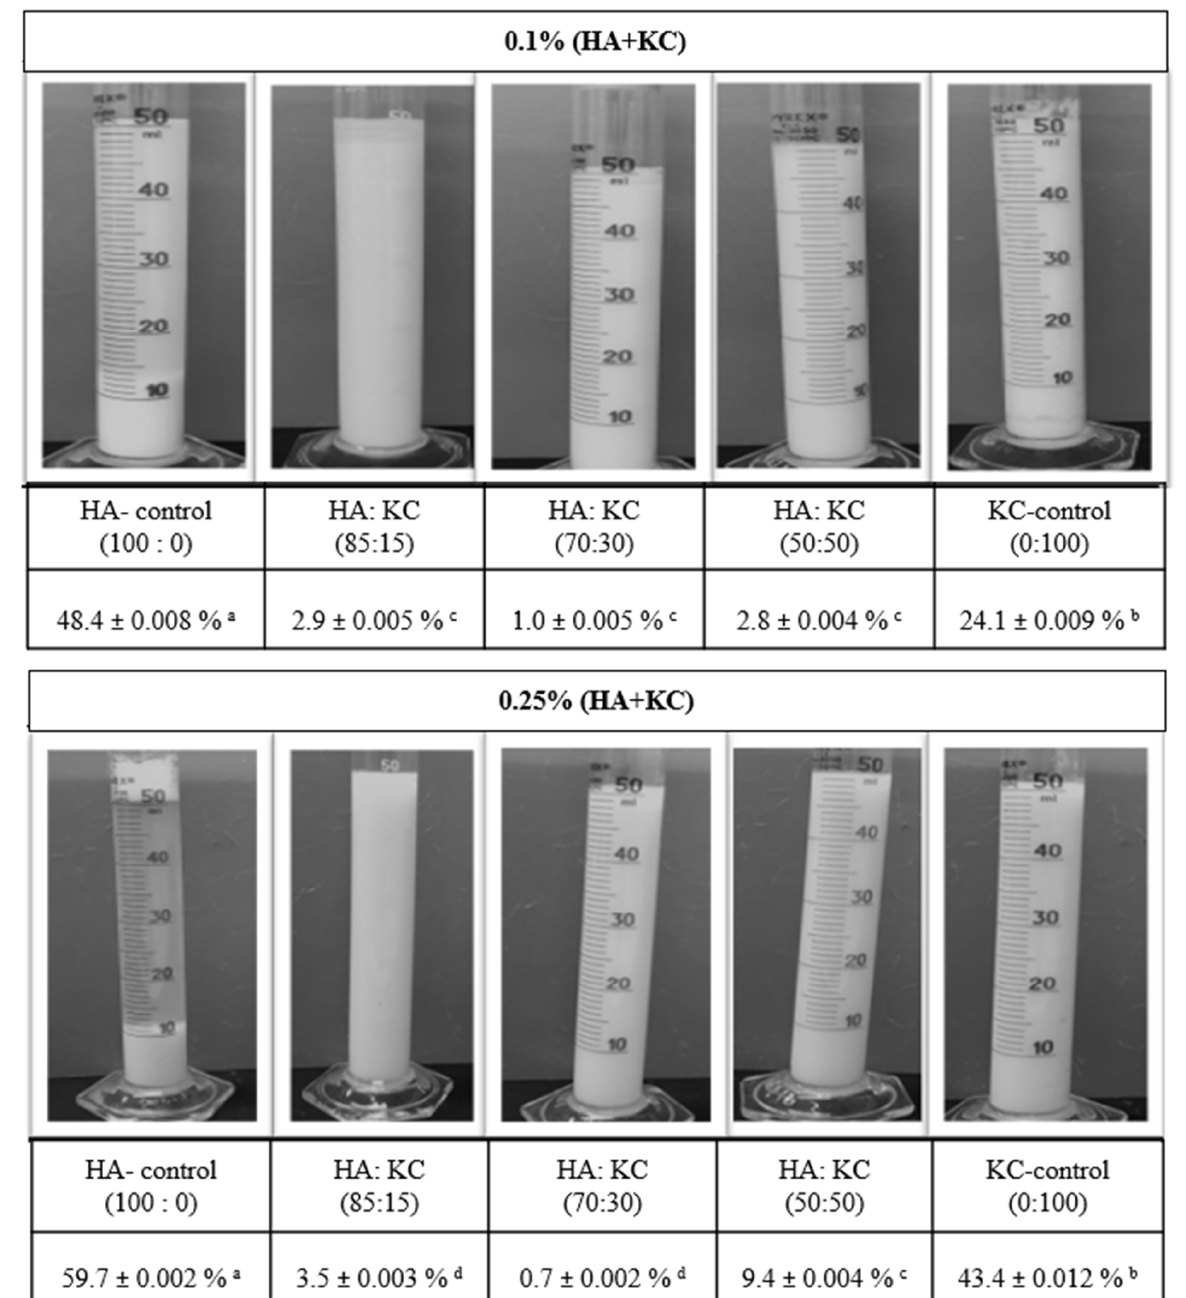
Figure 4. Protein phase separation of skim milk samples treated with different concentrations and ratios of HA + KC blend during storage (5 ◦ C for 48 h). All values in this table are the mean ( n = 3) ± the standard error of the mean. a–d completely different superscript letters in a table show significant differences ( p <